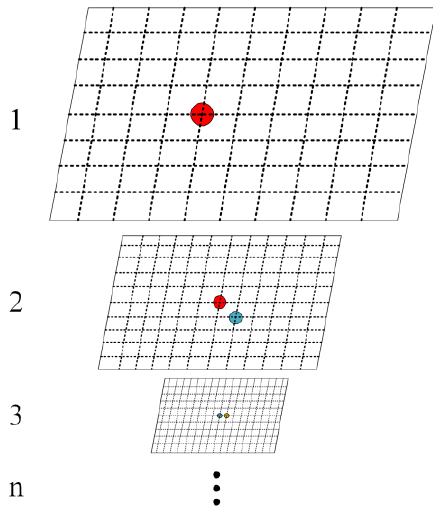
Figure 4. Schematic diagram of the principle of the pyramid registration method. The center of each layer represents the RMSE value of the elevation difference without translation, and each layer defines its own required step distance (the translation distance is represented by each grid). As the step distance decreases, the registration becomes increasingly accurate. The red, blue and yellow point represent the position of the minimum point during the registration of the first layer, second layer and third layer respectively, which is taken as the center point of the second layer, third layer and of the fourth layer.